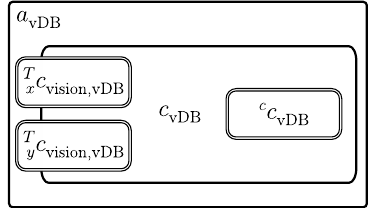
Figure 12. Structure of the agent a vDB .